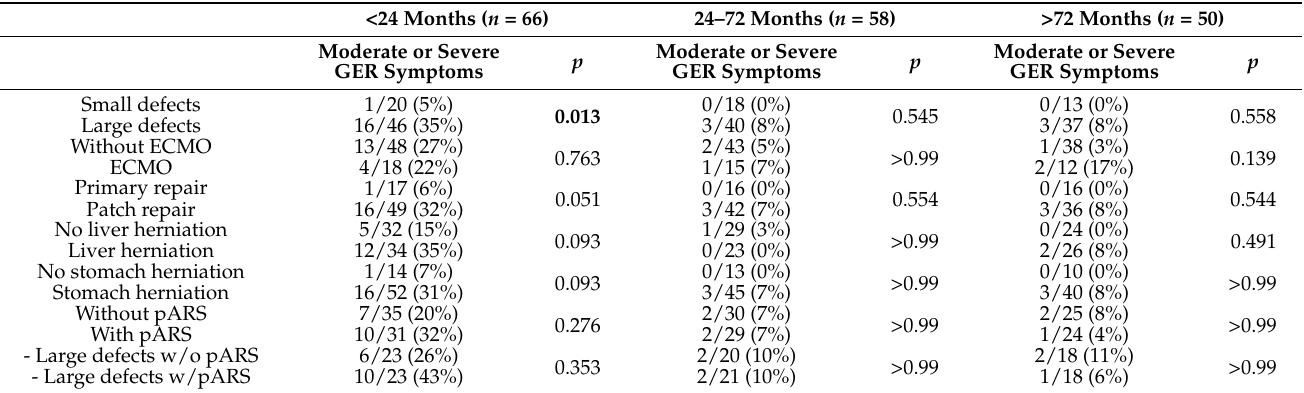
Table 2. Characteristics of patients with moderate or severe symptoms of GER at different time